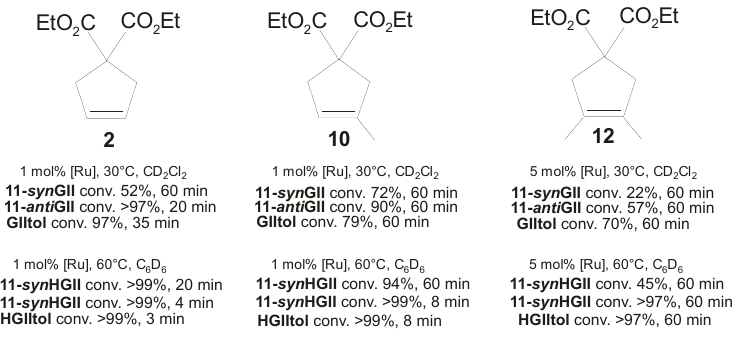
Figure 11. RCM to form cycloolefins 2 , 10 and 12 .